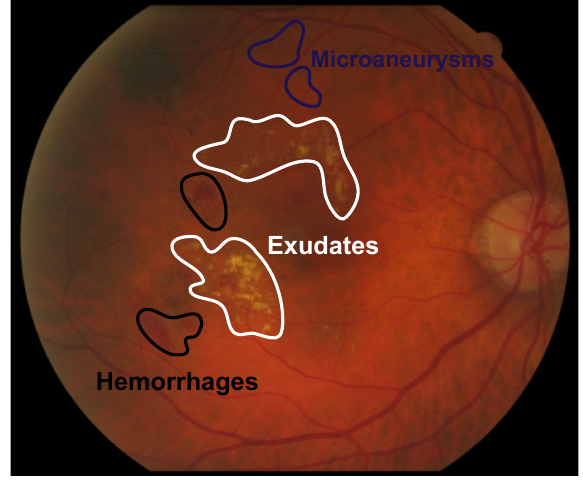
Figure 1. Example of exudates, microaneurysms and hemorrhages in fundus